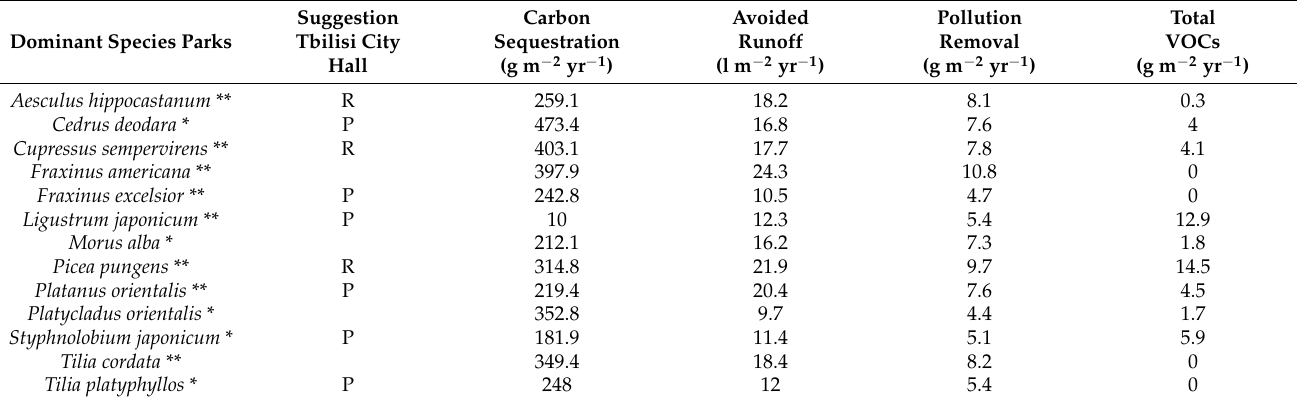
Table 3. Results per unit of canopy cover of dominant species in RED and EXPO parks. [** EXPO Park, * RED Park; R = Recommended, P = Priority]. Dominant Species